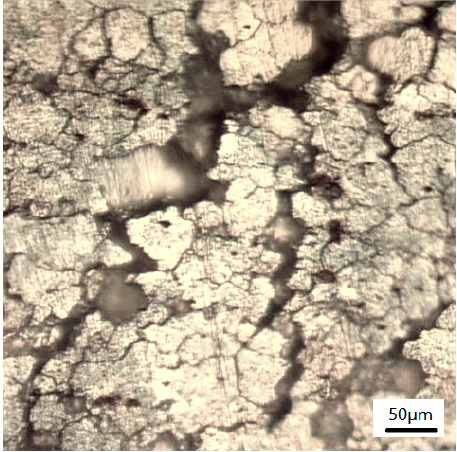
Figure 10. Weakened grain boundaries initiate fine microscopic cracks under the influence of a tensile stress (Duration of exposure = 16 h and applied stress ( σ ) of 118.5 stress (Duration of exposure = 16 h and applied stress ( σ ) of 118.5 MPa).